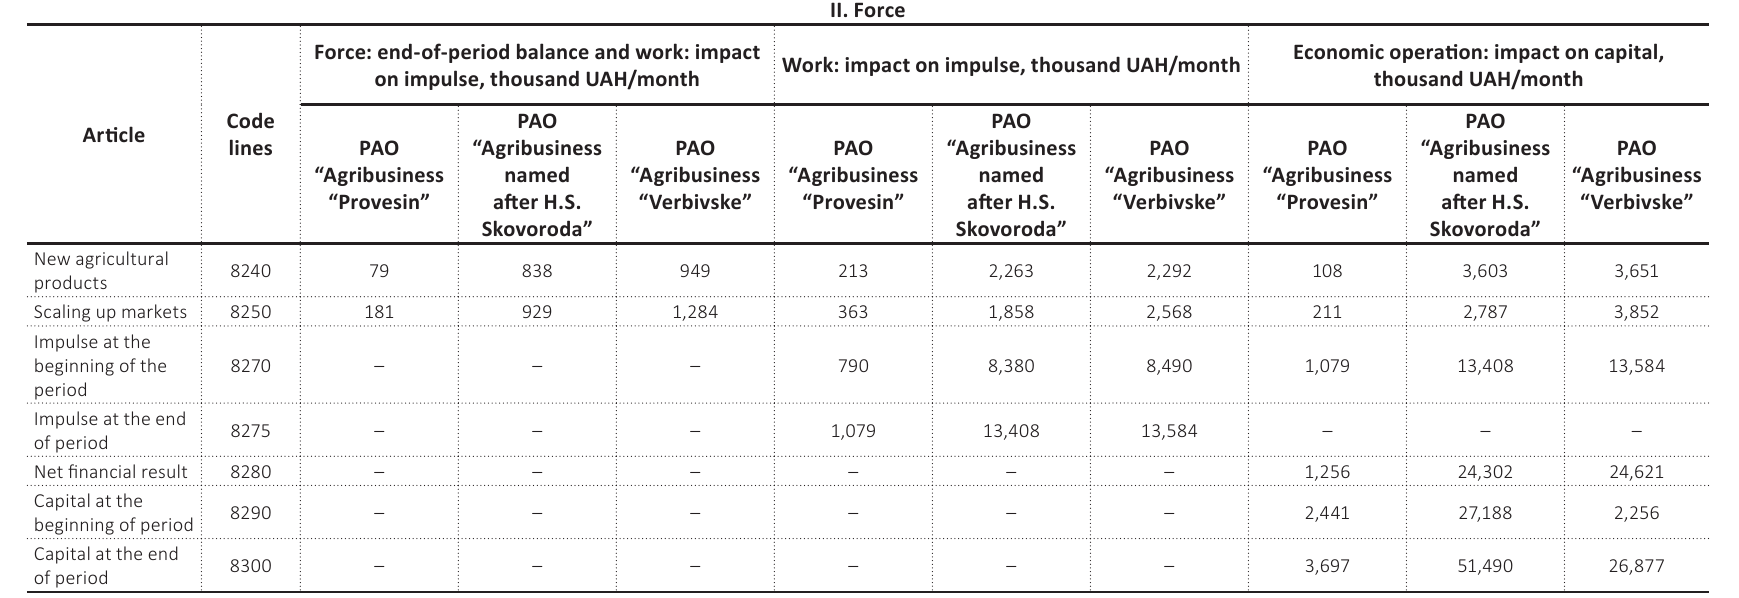
Force: end-of-period balance and work: